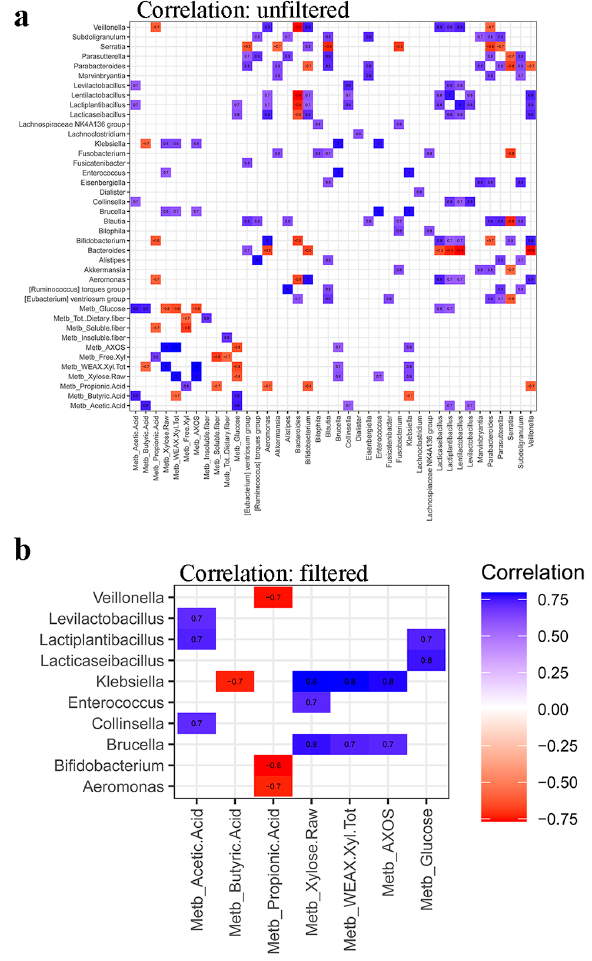
Figure 10. Pearson correlation among initial content of total xylose (Xylose Raw), WEAX Xyl Tot, Free Xyl, AXOS, glucose, short-chain fatty acids (propionic, butyric and acetic acids), insoluble, soluble and total dietary fibers, and microbial abundance in luminal samples after 2 weeks of treatment period. Panel ( a ) shows all and only statistically significant ( p < 0.05) correlations. Panel ( b ) highlights only significant ( p < 0.05) correlations between metabolites and microbial groups.